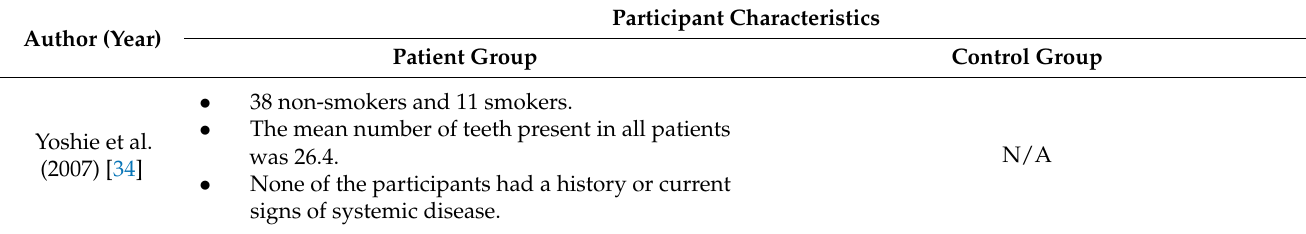
Table 1. Participant characteristics in the included